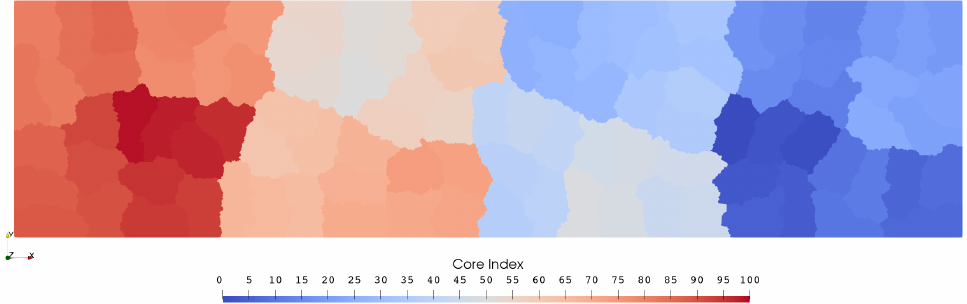
Figure 26. A 100-part mesh partitioning of the unstructured mesh used for generating Figures